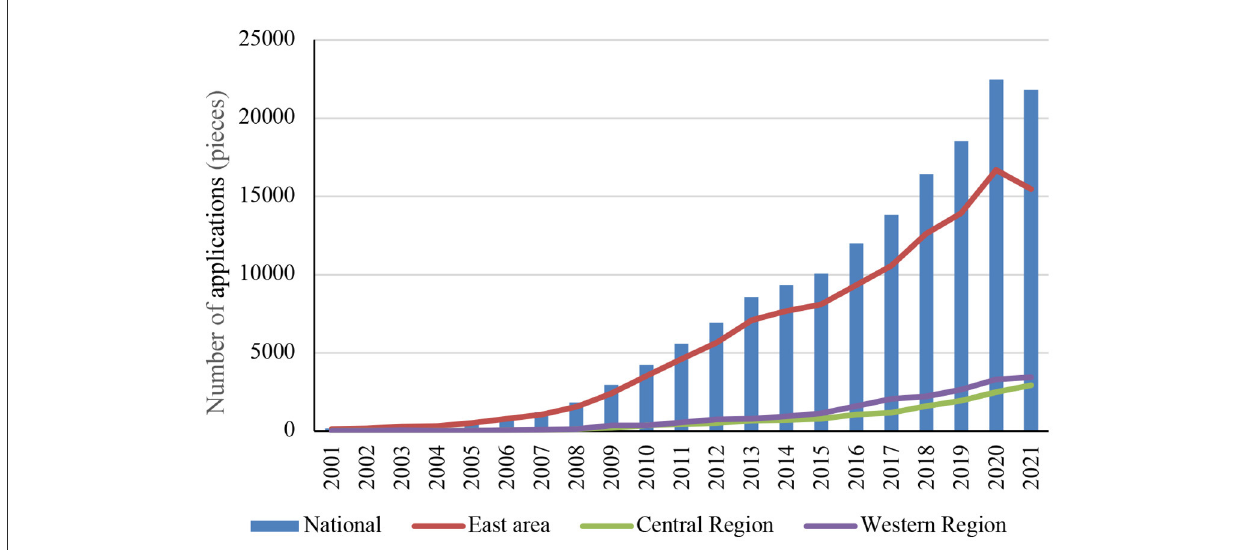
FIGURE1 Number of low-carbon patent applications nationwide and in the eastern, central, and western regions.